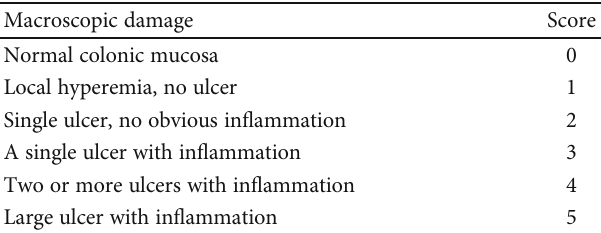
Table 2: Macroscopic damage